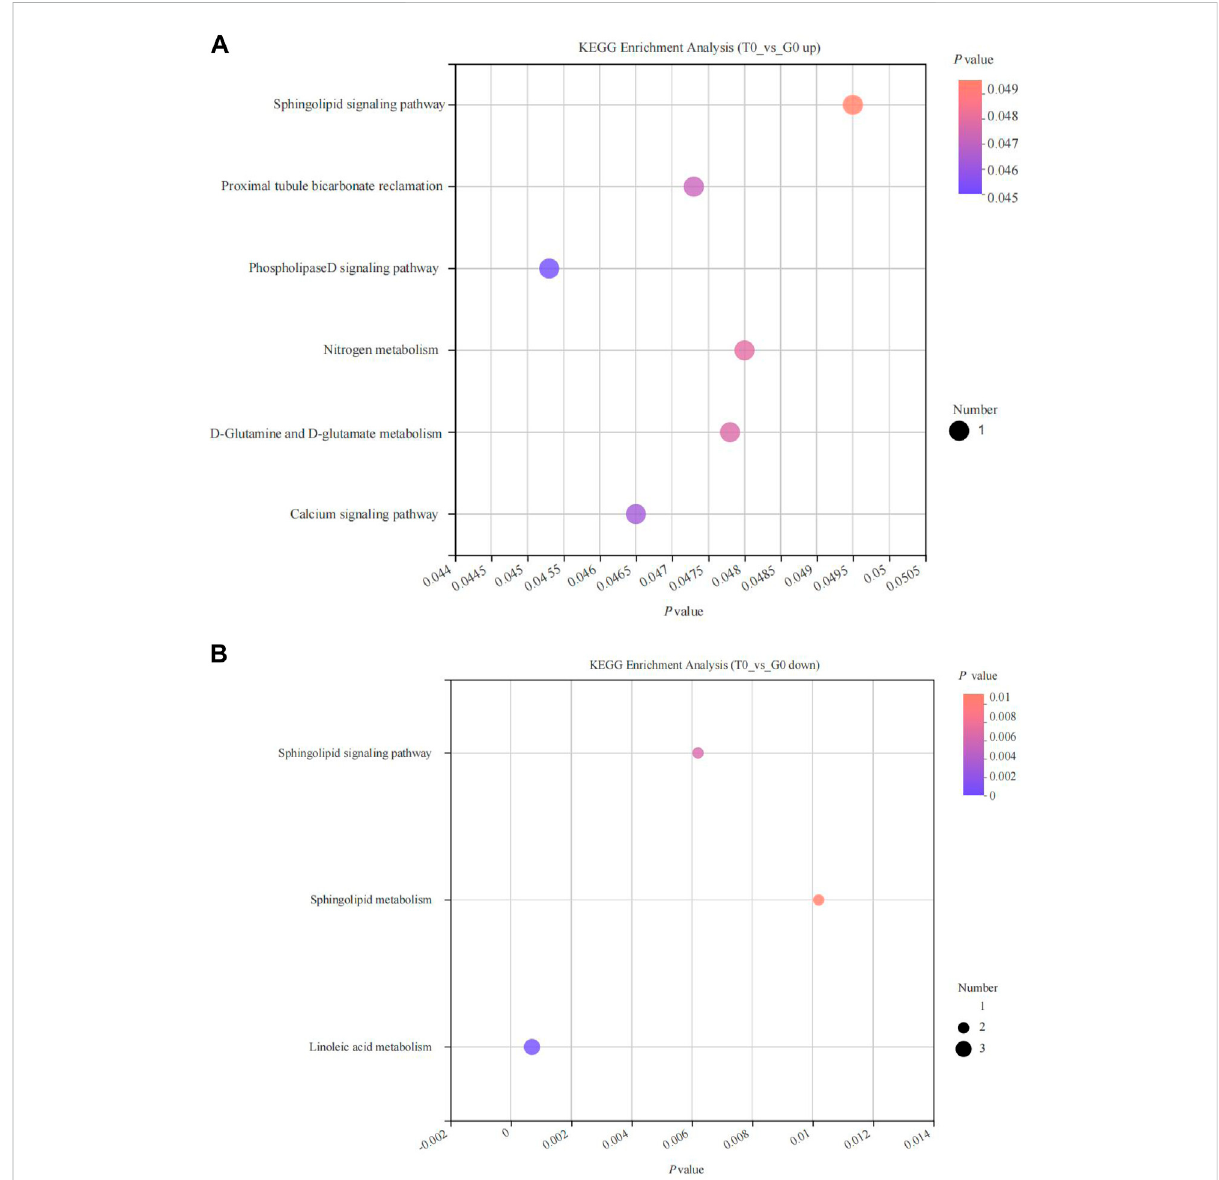
FIGURE 8 KEGG pathway enrichment analyses of differentially expressed metabolites derived from the fi sh subjected to cold stress. (A) upregulated metabolites. (B) downregulated